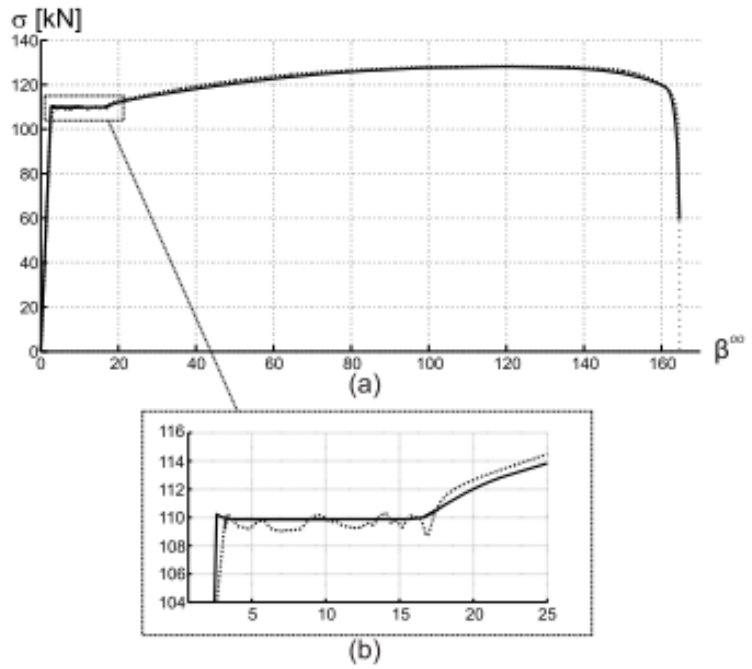
Figure 3: Force-elongation response curve for a steel bar in a numerical simulation with N = 6 and l = 80 mm, compared with the experimental response curve (the dotted line) (a). Detail of the plateau at the onset of the inelastic regime